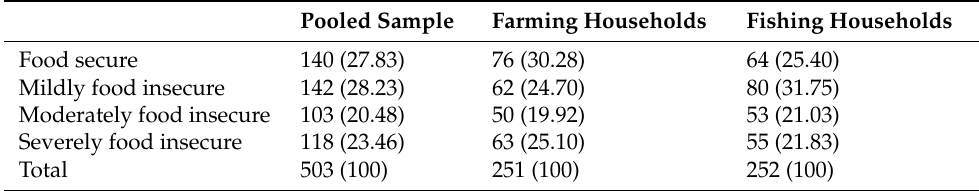
Table 4. Food security levels of farming and fishing households in the study area. Pooled Sample